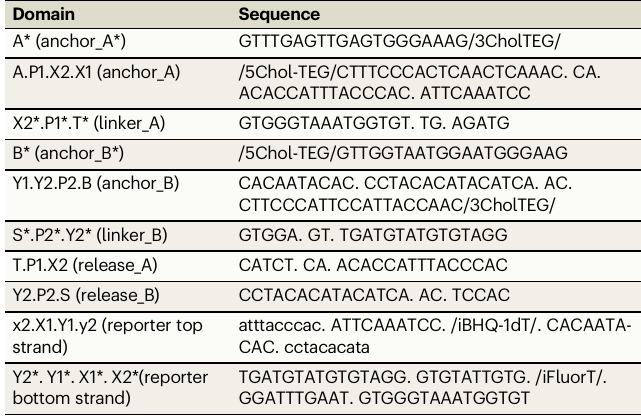
Table 1 | Domain-level sequences (5 ’— 3 ’ ) of two different types of DNA receptor and reporter